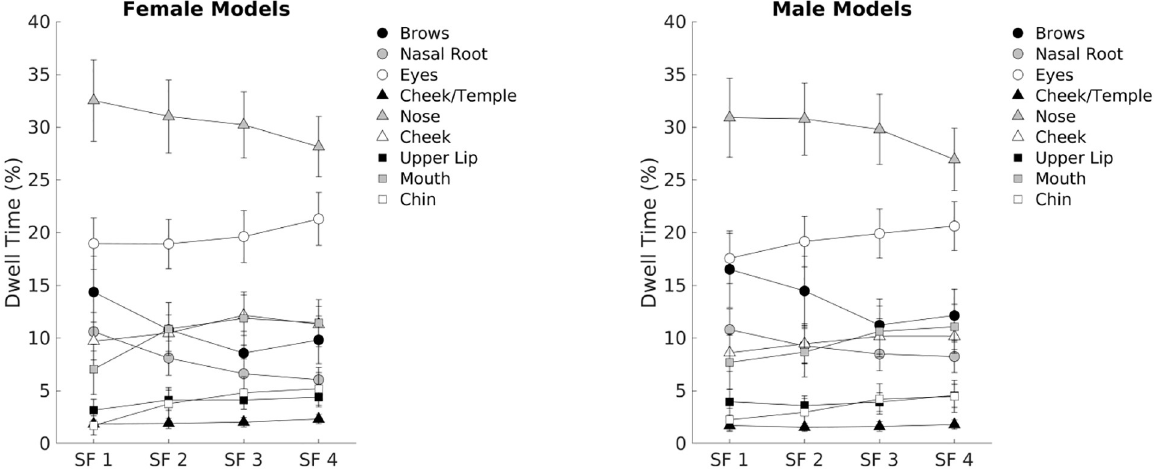
Fig 6. Percentage dwell times of gaze within each face parts, split by spatial frequency conditions and Face Gender. Error bars represent the 95% confidence intervals.